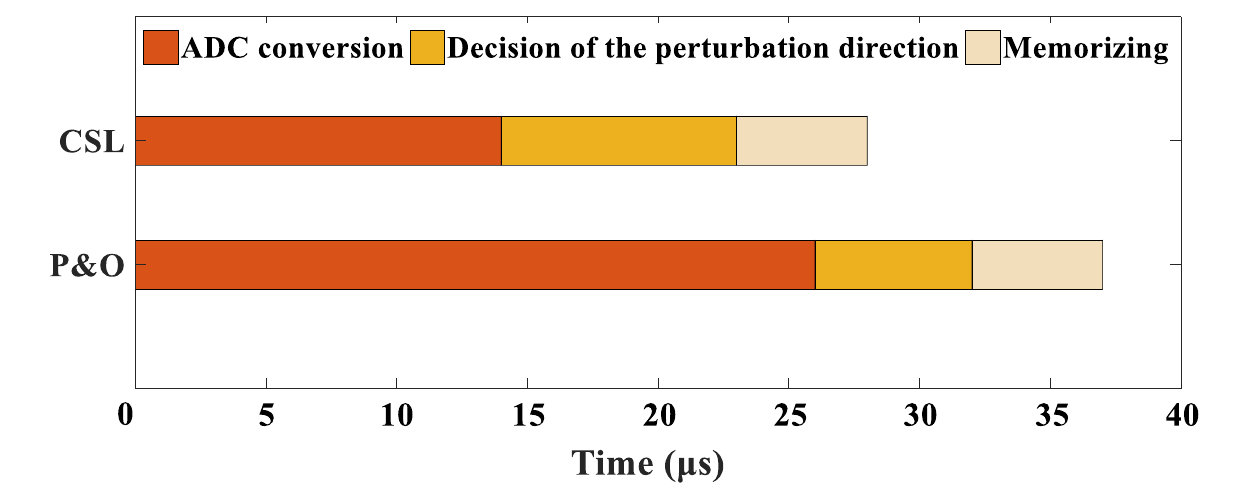
Figure 21. Comparison of the computation time required by the CSL and P&O algorithms. Table 4. Performance comparison between the proposed CSL and conventional P&O algorithm.